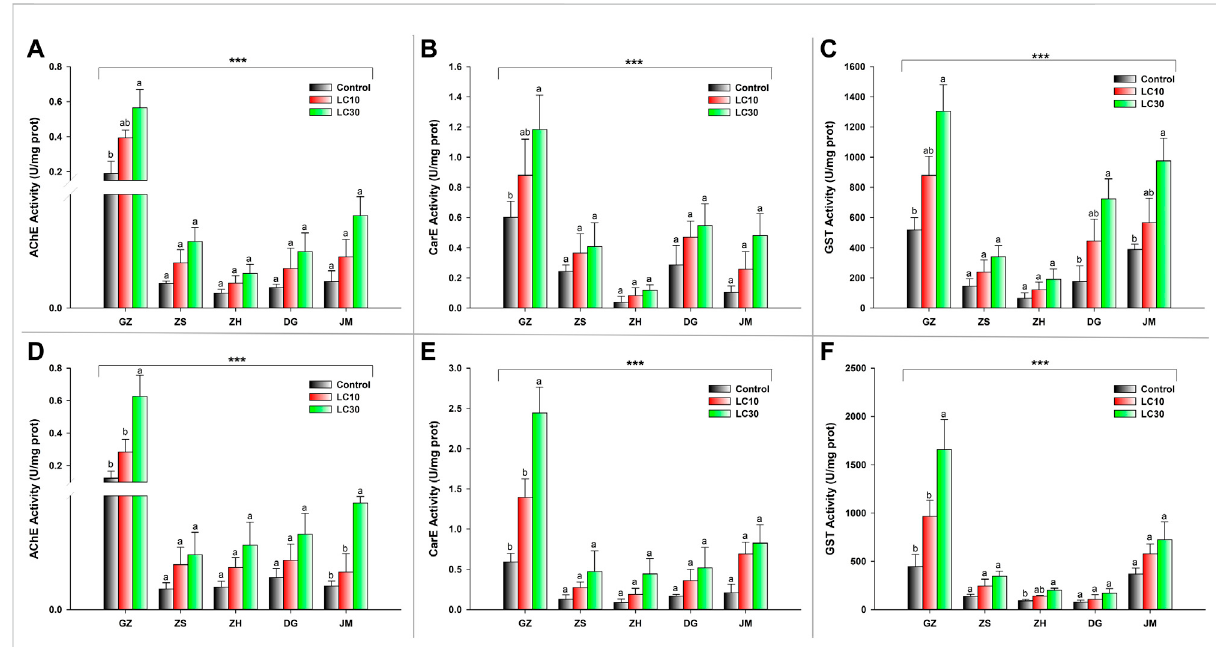
FIGURE 1 Enzyme activity of (A) AChE, (B) CarE, and (C) GST enzymes in response to beta-cypermethrin and (D) AChE, (E) CarE, and (F) GST enzymes in responseto fi pronilinthepopulationfromGZ,ZS,ZH,DGandJM.Thebarsrepresenttheaveragevaluesofthreereplicates.Thestandarderrorofthe mean is represented by error bars. The control and two treatments (LC 10 & LC 30 ) were compared using the Tukey HSD all-pairwise comparison test. Barswiththesamelettersfromaspeci fi cpopulationshowednonsigni fi cantdifferences,andasterisksindicatesigni fi cantdifferencesinenzyme activity between populations (** p < 0.05, *** p < 0.01, Tukey ’ s